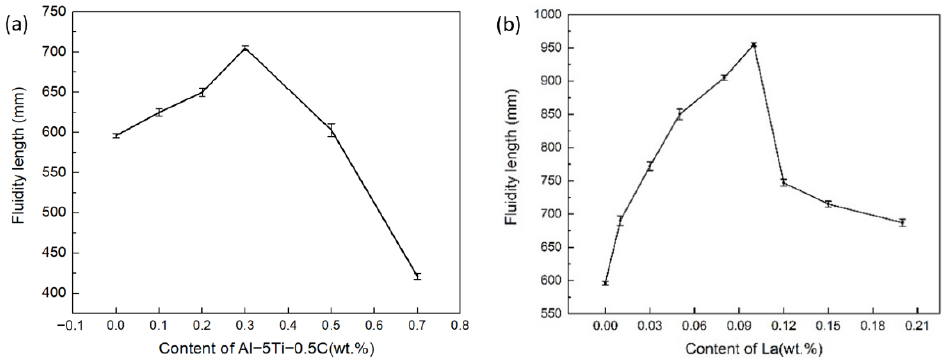
Figure 2. The fluidity of the ZL205A alloy with different levels of ( a ) Al − Ti − C and ( b ) La. Considering the beneficial effects of both Al–Ti–C and La on the fluidity of the ZL205A alloy, the effect of the combined addition of Al–Ti–C and La was investigated. The content of Al–Ti–C and La was chosen to be 0.3% and 0.1%, respectively, in accordance with their optimal contents when added separately. The results are shown in Figure 3. The fluidity of the untreated ZL205A and the alloy with the addition of either Al–Ti–C or La are also plotted for comparison. The combined addition of Al–Ti–C and La demonstrated the highest fluidity, with an increase in the spiral sample’s length by 74% compared with the untreated alloy.